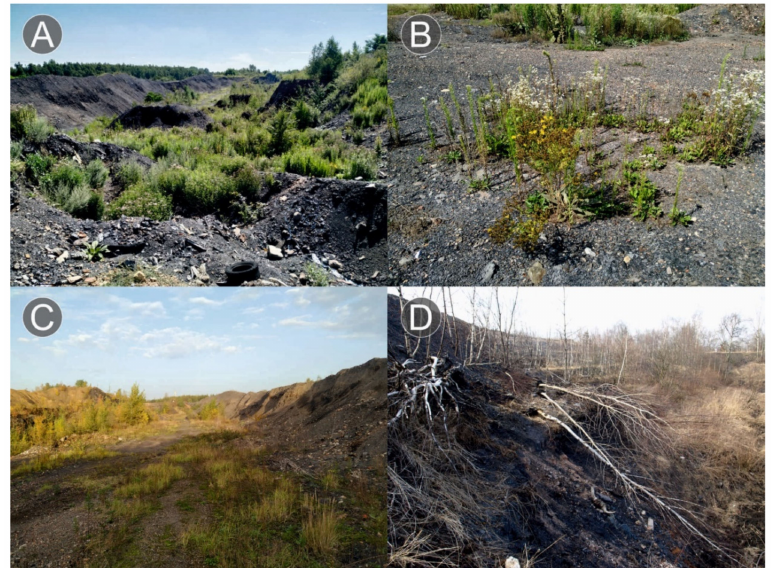
Figure 10. Plant cover on the coal-waste dump in D-B-2: ( A ) dense patch of Eupatorium cannabinum (28 July 2020; Figure 9—Ia), ( B ) a loose patch of Hypericum perforatum and Erigeron annuus (28 July 2020; Figure 9—I), ( C ) loose sod at the bottom of the dump (09 July 2020; Figure 9—II), and ( D ) destroyed community with Betula pendula (30 October 2019; Figure